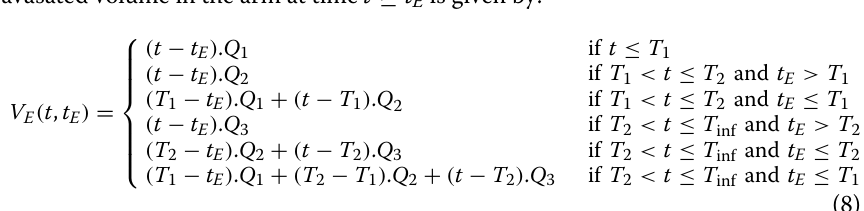
Fig. 3 Illustration of the time delay ( T delay ) between the vial concentration and the fluid element concentration as a function of time t and the position of the fluid element in cylindrical coordinates ( s , r ) . A For t < T 1 , the fluid element traveled the distance s at the velocity between the fluid element curvilinear abscissa s and the velocity there are two cases depending on the curvilinear abscissa s of the fluid element: Case 1. s ≤ D 2 ( r , t ) , the fluid element has traveled the distance s at the velocity element has traveled the distance D 2 ( r , t ) at the velocity −→ v D 2 ( r , t ) r ) ( T ) . C For t > T 2 , there are three cases depending on the curvilinear abscissa s + s − D 2 ( r , t ) −→ −→ v 1 ( delay = v 1 ( r ) 2 ( r ) of the fluid element. The mathematical expression of T delay is obtained by following the same method as for T t ≤ T 1 <